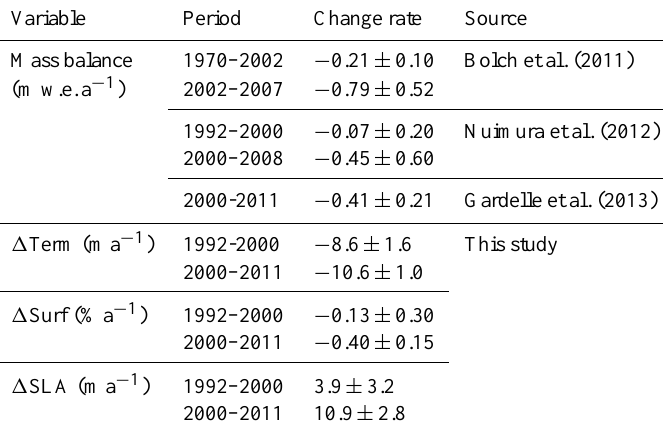
Table 3. Rates of mass balance, 1 Term, 1 Surf, and 1 SLA for 10 common